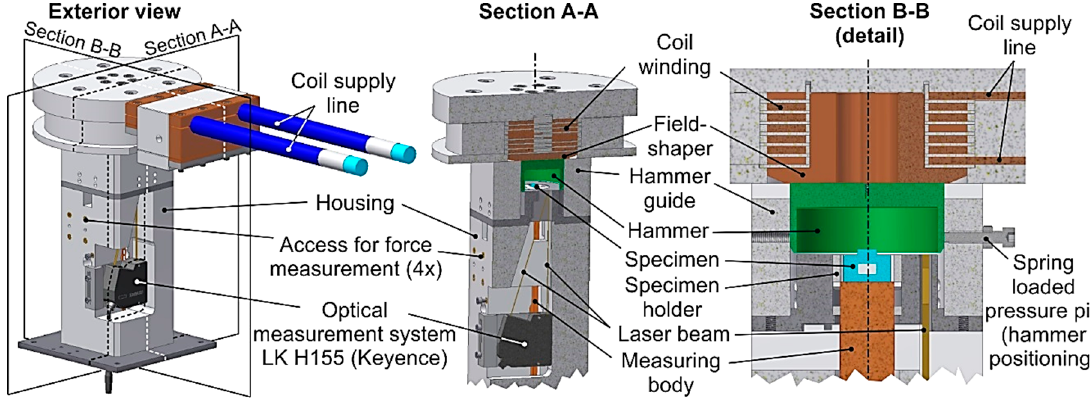
Figure 7. Design of the experimental setup with electromagnetically driven tools.